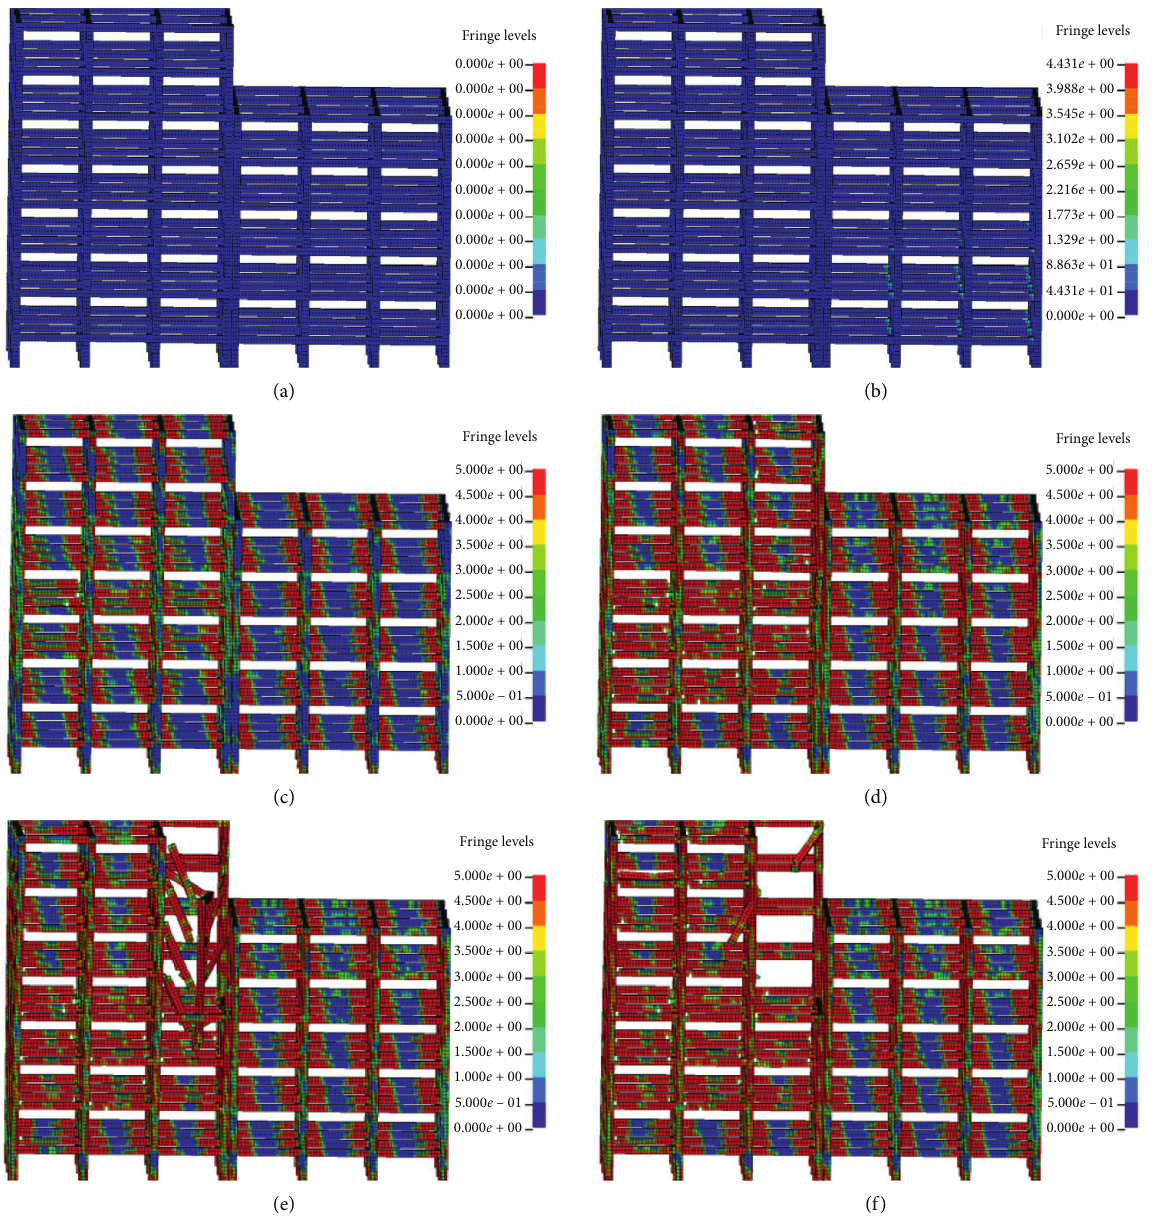
Figure 8: Collapse impact process of weak column GK-3 (PGA � 0.40g): (a) t � 0.00s; (b) t � 1.58s; (c) t � 8.27s; (d) t � 10.38s; (e) t � 11.32s; and (f) t �